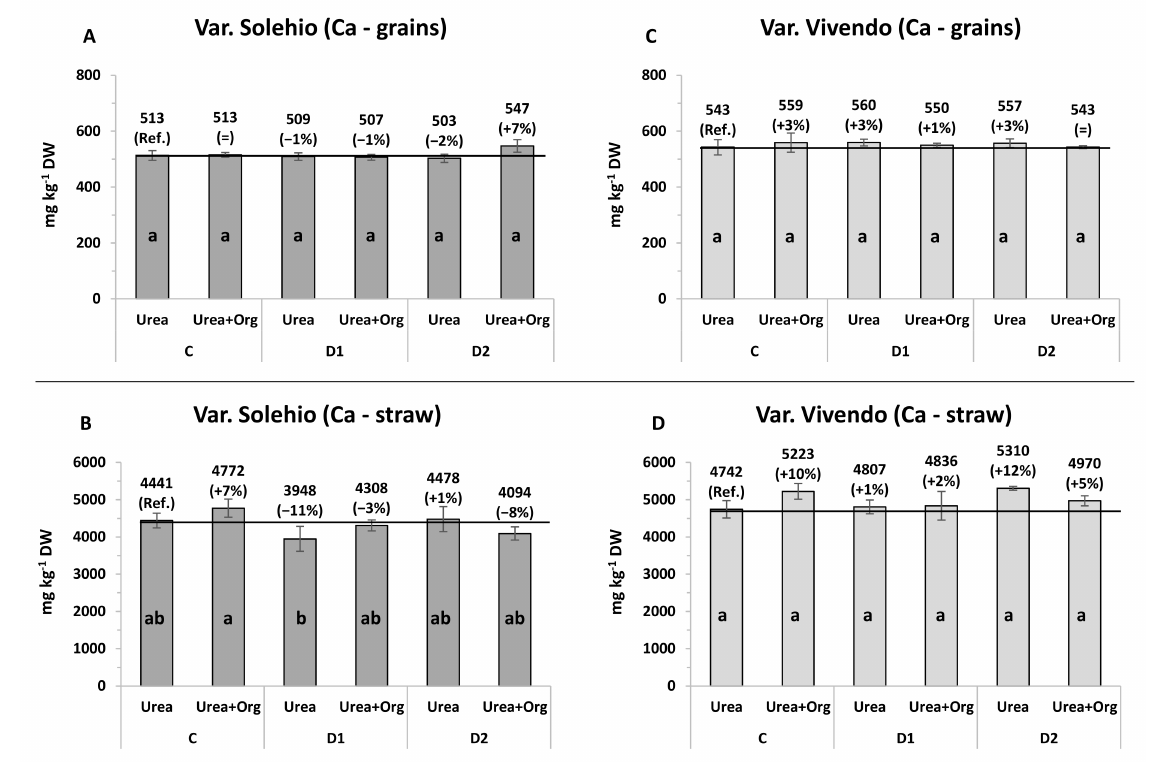
Figure 2. Calcium concentration (mean ± S.E.; n = 3) in grains and straw at harvest in the wheat varieties Solehio ( A , B ) and Vivendo ( C , D ) following the biofortification treatment with D1 and D2 doses of Ca + Mg + K, applied together with urea (Urea) and urea + organic (Urea + Org) nitrogen fertiliser, and in the two controls C_Urea and C_Urea + Org without cations. Letters above histograms indicate significant differences between treatments (Student–Newman–Keuls test; p ≤ 0.05). In brackets: % variation of treatments vs. urea control